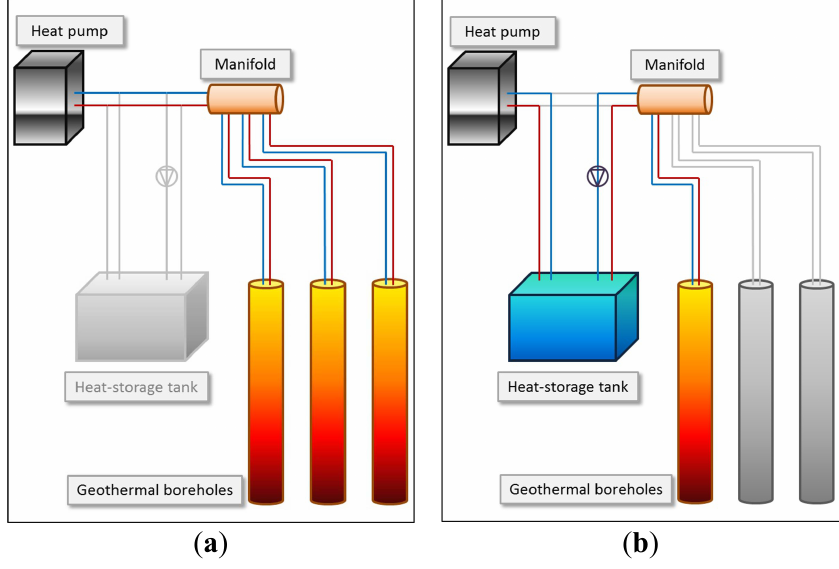
Figure 4. Geothermal heat pump (GHP) layout: ( a ) conventional working mode; and ( b ) alternative working